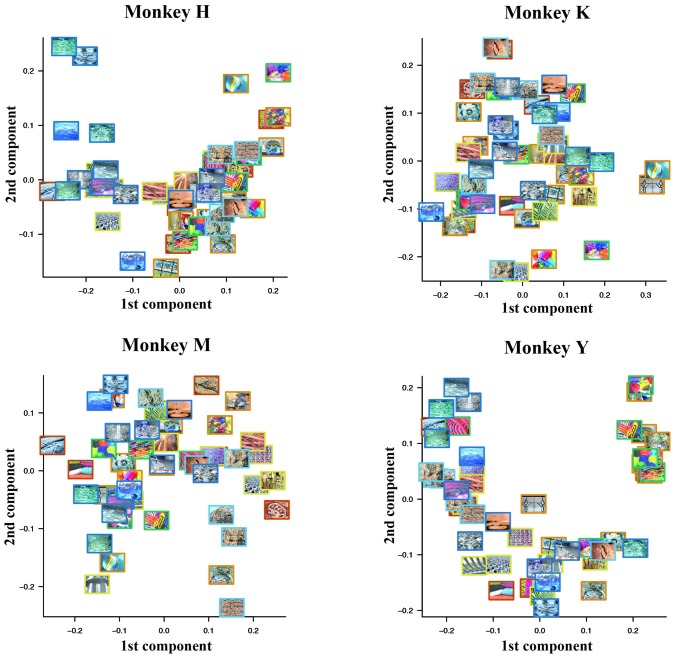
Psychological similarity among the 50 visual stimuli calculated from the choice ratios of these stimuli. We first calculated the psychological distance between two stimuli arbitrarily selected from the pool of 50 stimuli using the choice ratio of each stimulus. After we constructed a distance matrix using the obtained psychological distances among the 50 visual stimuli, we applied 2-D multi-dimensional scaling to this distance matrix. Monkey H seemed to classify the 50 stimuli into two groups based on their colorfulness and complexity; one group includes rather simple and monotone stimuli and the other group includes rather complex and colorful stimuli. A similar tendency for such classification was observed in Monkeys M and Y.